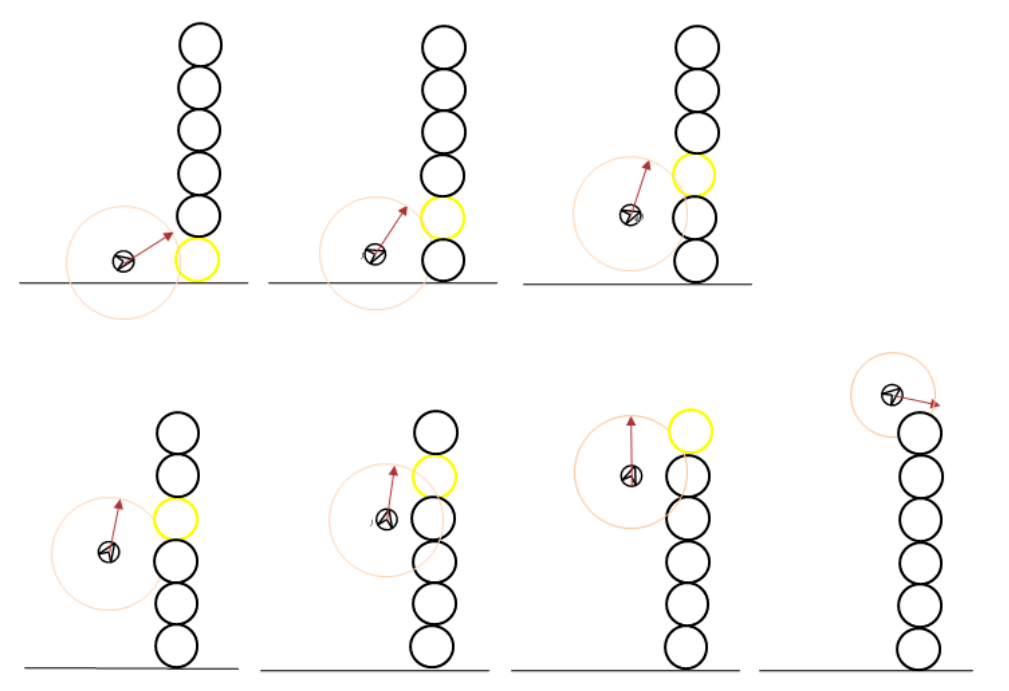
Figure 21. Schematic diagram of the agent avoiding obstacles.